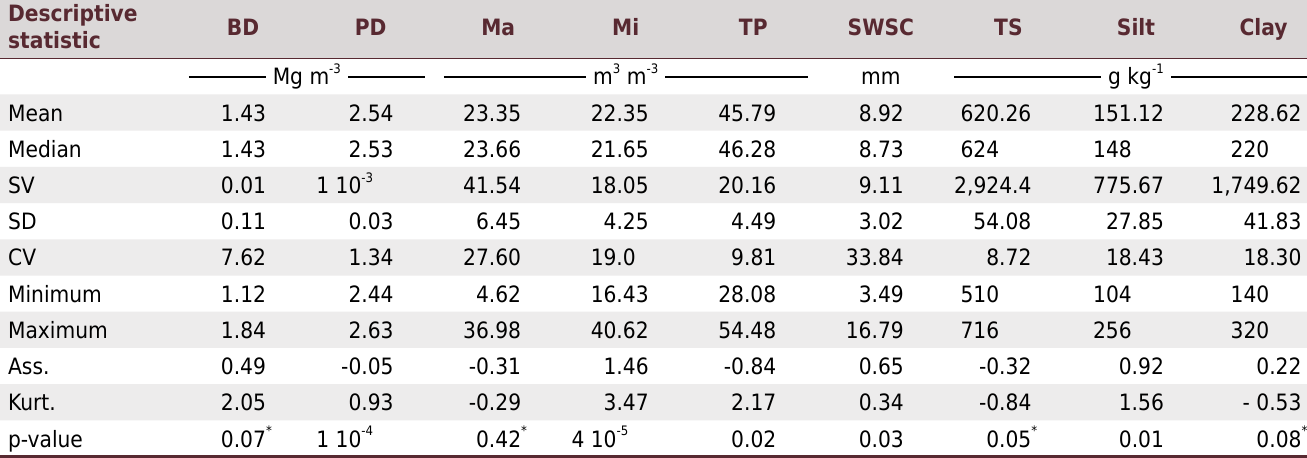
SV: sample variance; SD: standard deviation; CV: coefficient of variation; Ass.: asymmetry coefficient; Kurt.: kurtosis coefficient. * : normal distribution by the Shapiro-Wilk test at 5 %